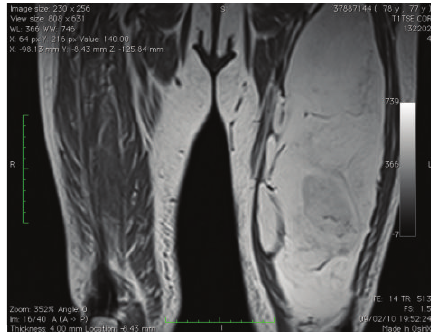
Figure 3: MRI of a lipomatous tumor in the anterior compartment of the thigh.